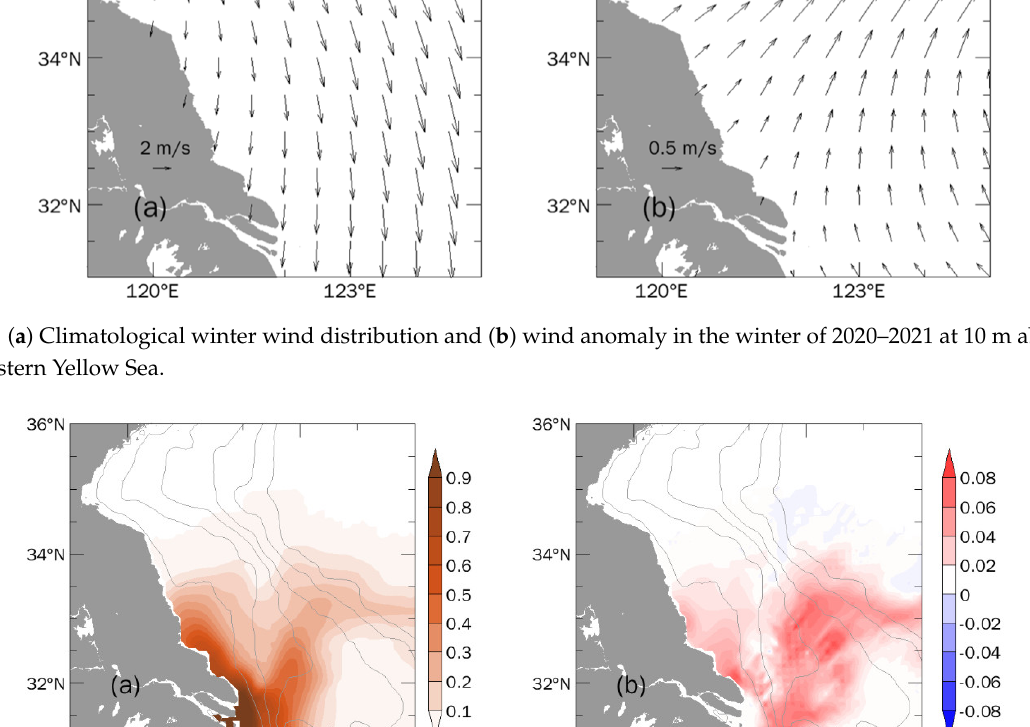
Figure 7. ( a ) Climatological winter wind distribution and ( b ) wind anomaly in the winter of 2020–2021 at 10 m above the southwestern Yellow Sea.